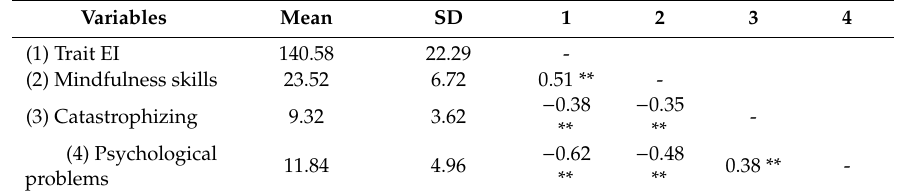
Table 3. Descriptive statistics and bivariate correlations among the